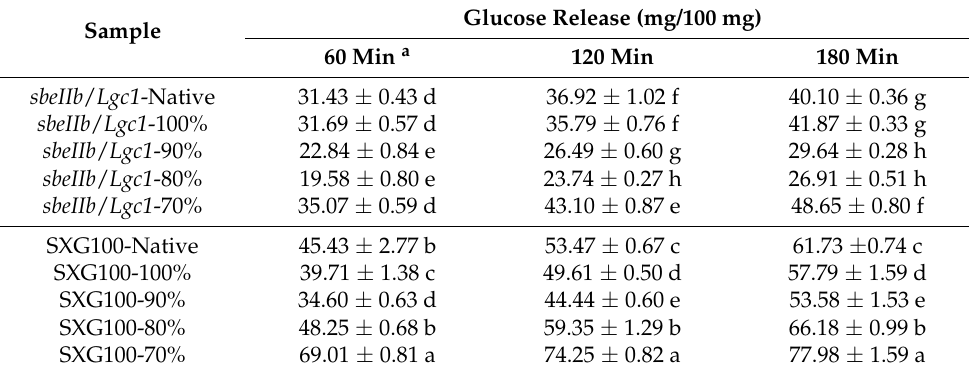
Table 1. The in vitro digestibility of native and HMT rice flours of sbeIIb / Lgc1 and